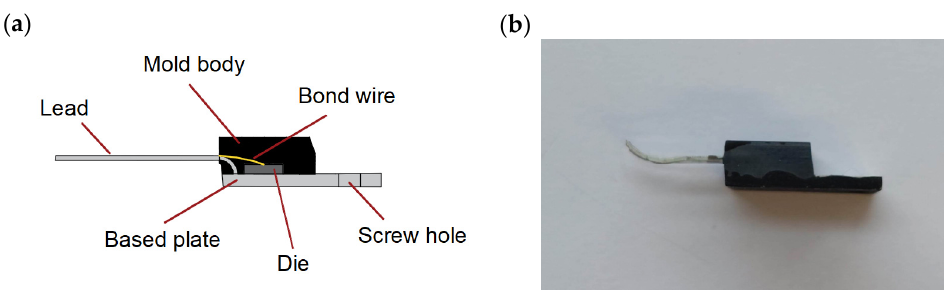
Figure 1. Construction of an exemplary semiconductor element placed in ( a ) TO-220 cross-section, ( b ) TO-220 view.